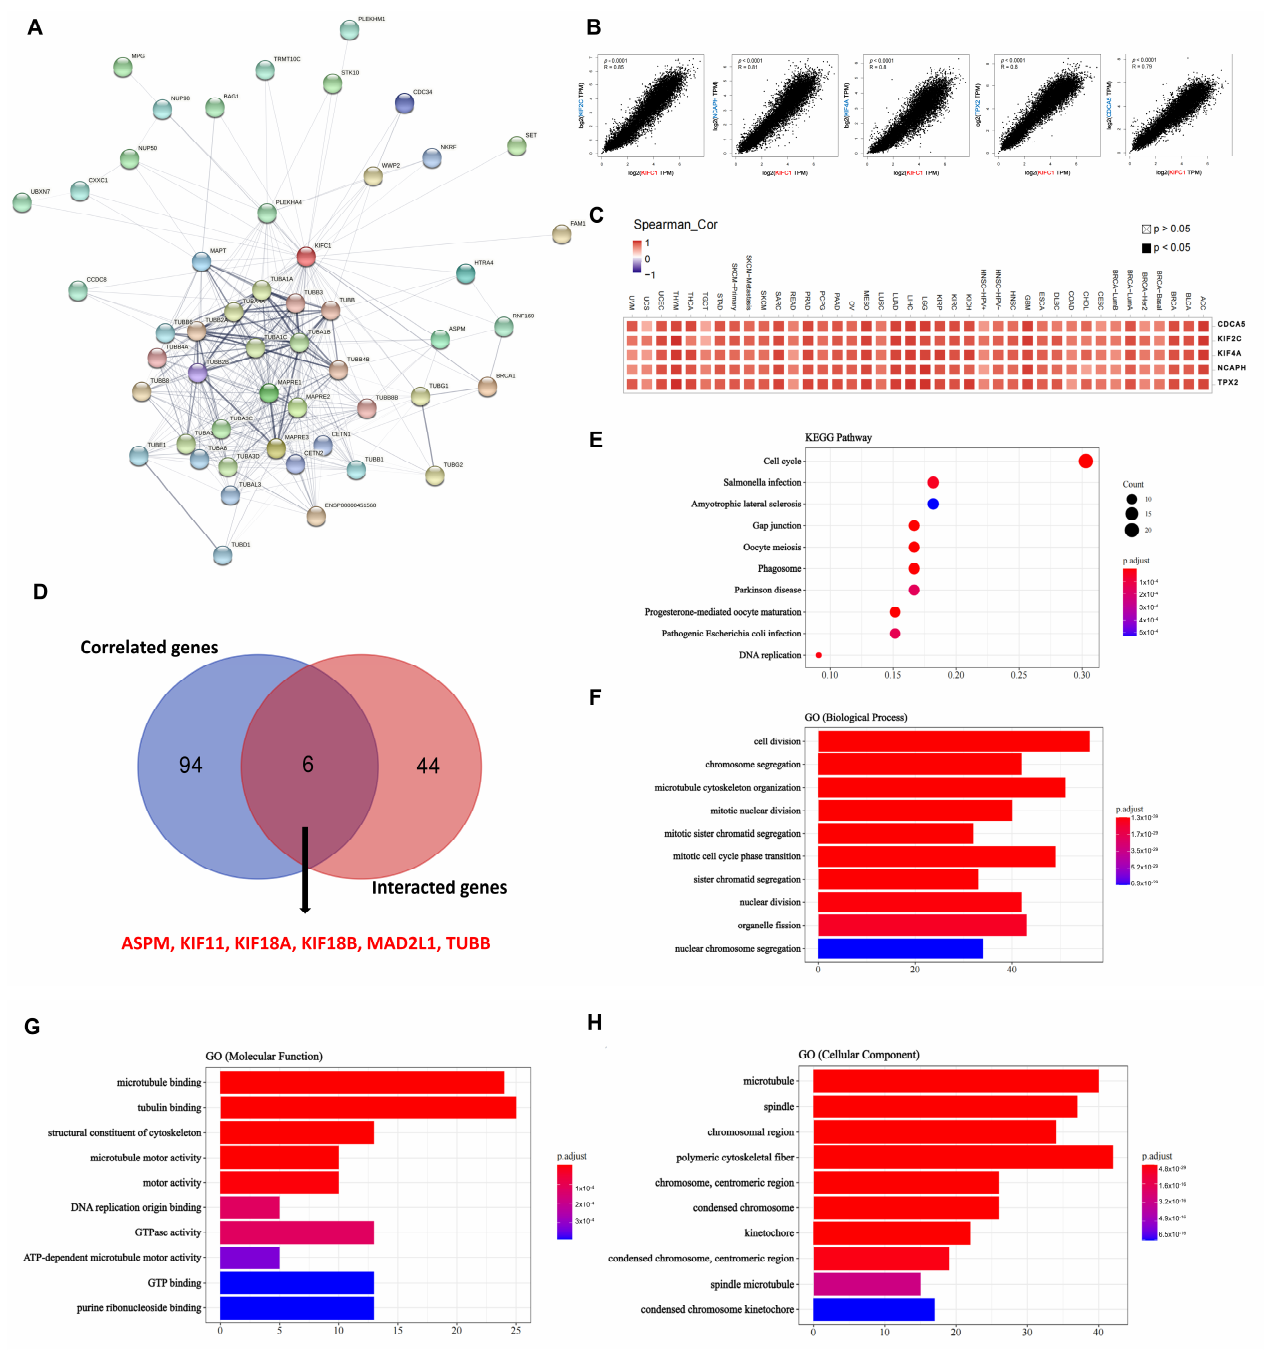
Figure 5. KIFC1-related gene network, KEGG pathway analysis, and GO enrichment analysis. ( A ) A total of 50 available experimentally determined KIFC1-interacted proteins using STRING tool. ( B ) Top 100 KIFC1 -correlated genes in TCGA database and selected targeting genes, including CDCA5 , KIF2C , KIF4A , NCAPH , and TPX2 , in Pearson’s correlation coefficients. ( C ) The corresponding heatmaps of